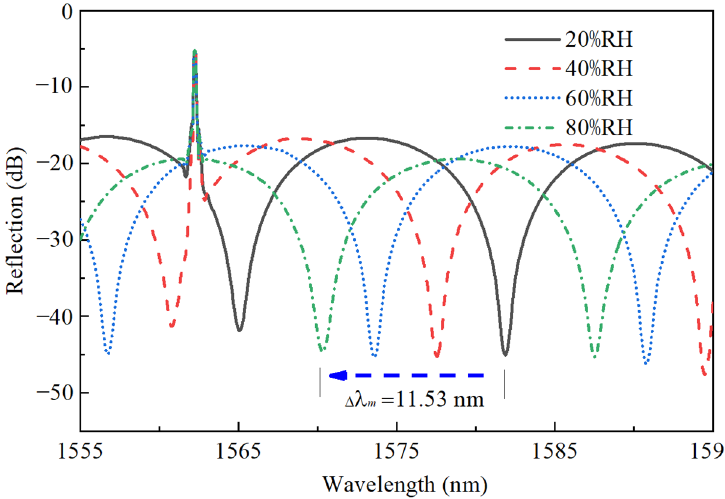
Figure 4. Spectra of the FPI probe at different relative humidity.